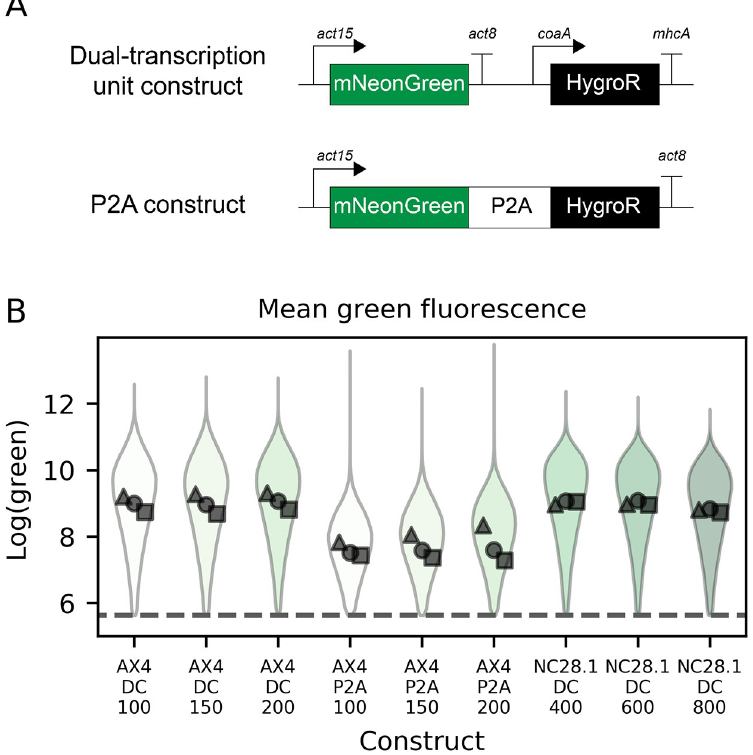
Fig 4. Linking gene of interest to hygromycin expression cassette lowers overall expression. A: Constructs transfected into D. discoideum cells. In the dual-transcriptional unit construct the mNeonGreen is driven by an actin15 promoter and has an actin8 terminator while the hygromycin resistance gene is driven by a coaA promoter and has a mhcA terminator. In the P2A construct, mNeonGreen-P2A-HygroR is driven by an actin15 promoter and has an actin8 terminator. B: Mean green expression in either AX4 or NC28.1 measured by flow cytometry. The violin plot represents the aggregate single-cell data from three independent transfections, while each individual point is the mean expression level of one transfection. Dashed lines represent fluorescence thresholds. X-axis labels indicate whether the dual cassette (DC) or the P2A construct was used, alongside the hygromycin concentration in μ g/ml. Each marker shape indicates an independent experiment ( 4 : replicate 1, ◯ : replicate 2, □ : replicate